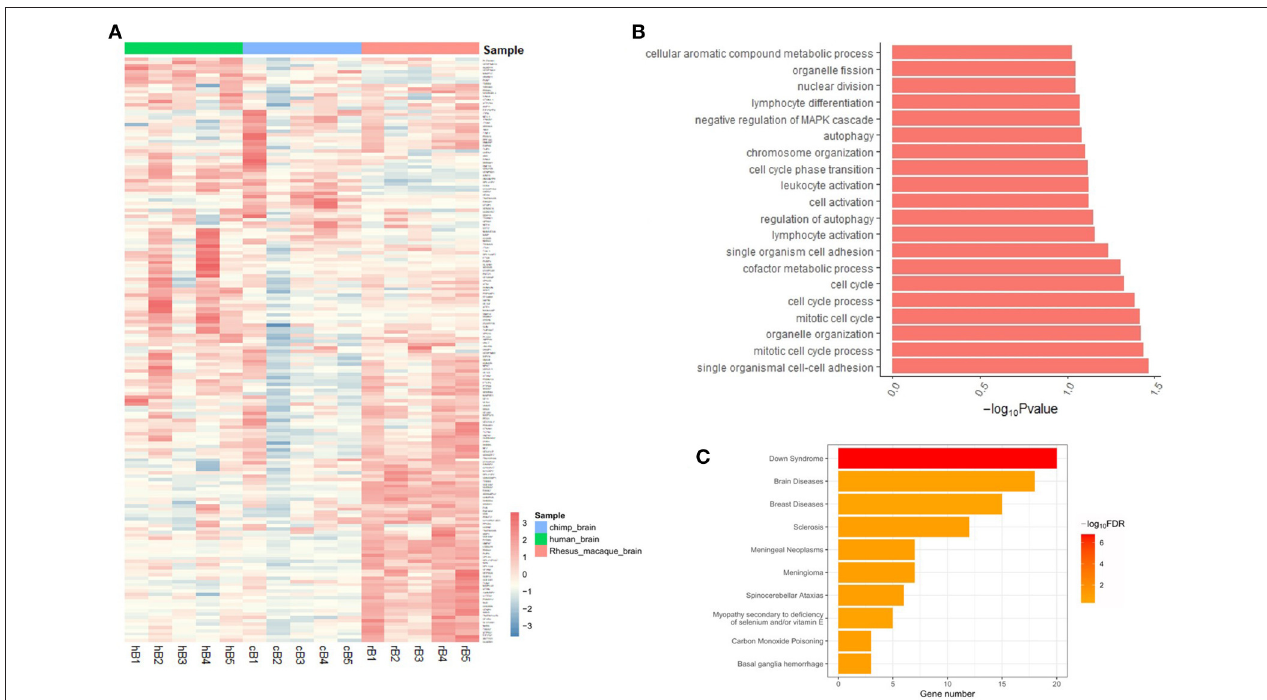
FIGURE 2 | (A) Expression profiles of target genes in human, chimp, and macaque brain tissues. Genes with expression data from all three species were selected and normalized Z-scores generated. (B) Functional enrichment analysis of brain-aceDHS target genes using DAVID. (C) Disease enrichment analysis of brain-aceDHS target genes in the GLAD4U